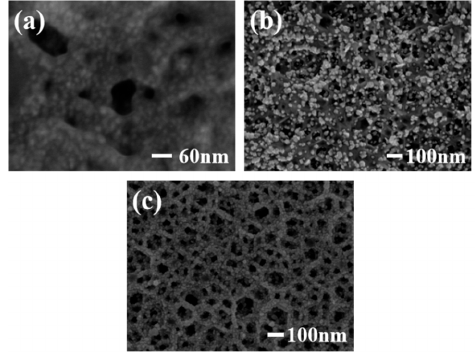
Figure 2. SEM images of ( a ) Pt/PGaN, ( b ) Pd/PGaN and ( c ) Pd-Pt/PGaN electrodes.